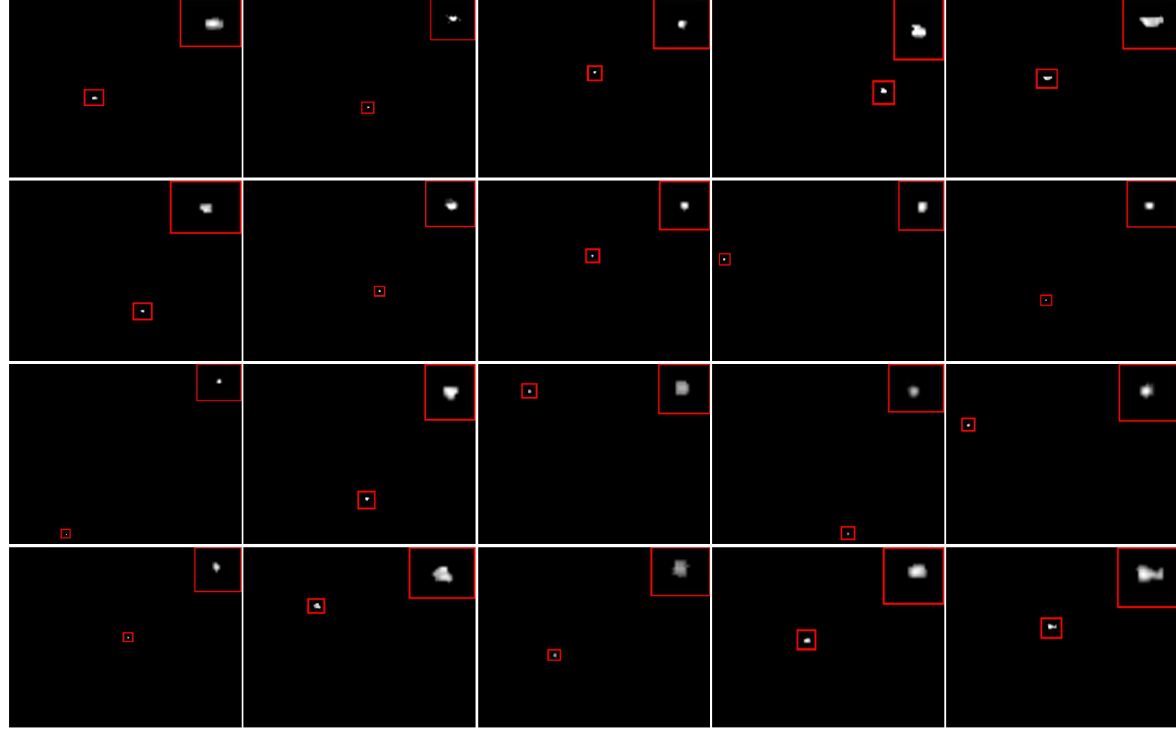
Figure 9. Process output of proposed method for 20 single-frame images.